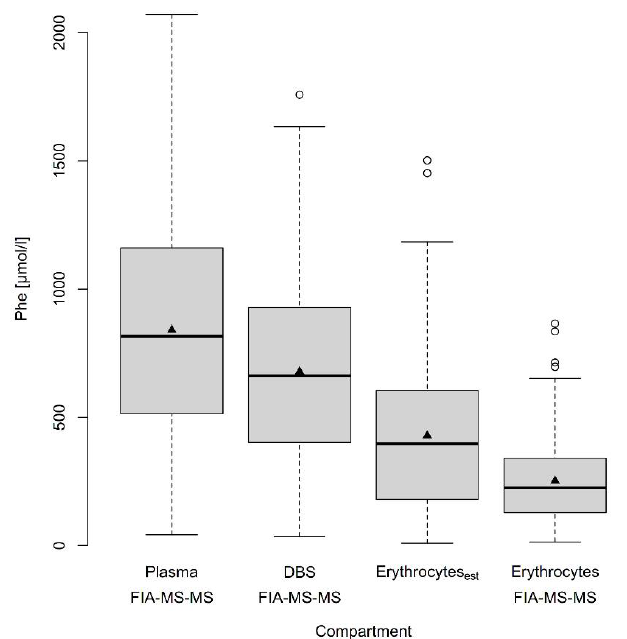
Figure 3. Boxplot of Phe concentrations in different blood compartments (n = 224) measured by FIA-MS-MS and of estimated Phe concentrations in erythrocytes. Boxes show interquartile ranges (25th and 75th quantiles), thick lines inside the boxes represent the median (50th quantile), and triangles the arithmetic mean. The whiskers extend to the maximum of data points not higher or lower than 1.5 times the interquartile range from the boxes. Circles indicate extreme values.